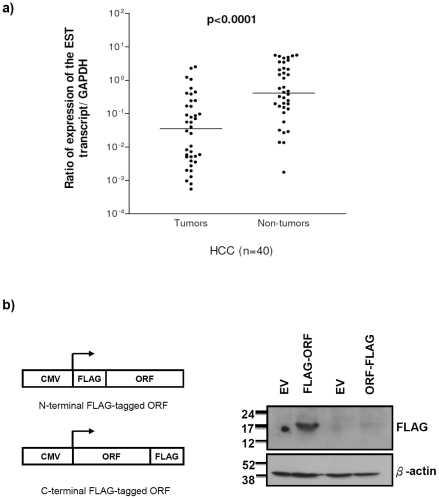
Expression of the EST in human HCCs and cell line.(A) Quantitative expression analysis of the EST transcript in the HBV-associated HCCs showed that the EST transcript was significantly under-expressed in HCC tumors when compared with the corresponding non-tumorous livers (P<0.0001, non-parametric paired t-test). Dots: the ratio of expression level of the transcript versus the level of GAPDH in each testing sample. Horizontal lines: mean of the relative expression level in the HCC tumors and non-tumorous livers. (B) Left panel: Schematic diagram of the FLAG-tagged expression constructs. Right panel: Western blot analysis of FLAG-tagged EST translation in HepG2 cell line. The FLAG-tag could be translated only when tagged at the N-terminus of the ORF but not at the C-terminus. β-actin served as a loading control. EV: empty vector, FLAG-ORF: N-terminal FLAG-tagged ORF, ORF-FLAG: C-terminal FLAG-tagged ORF.